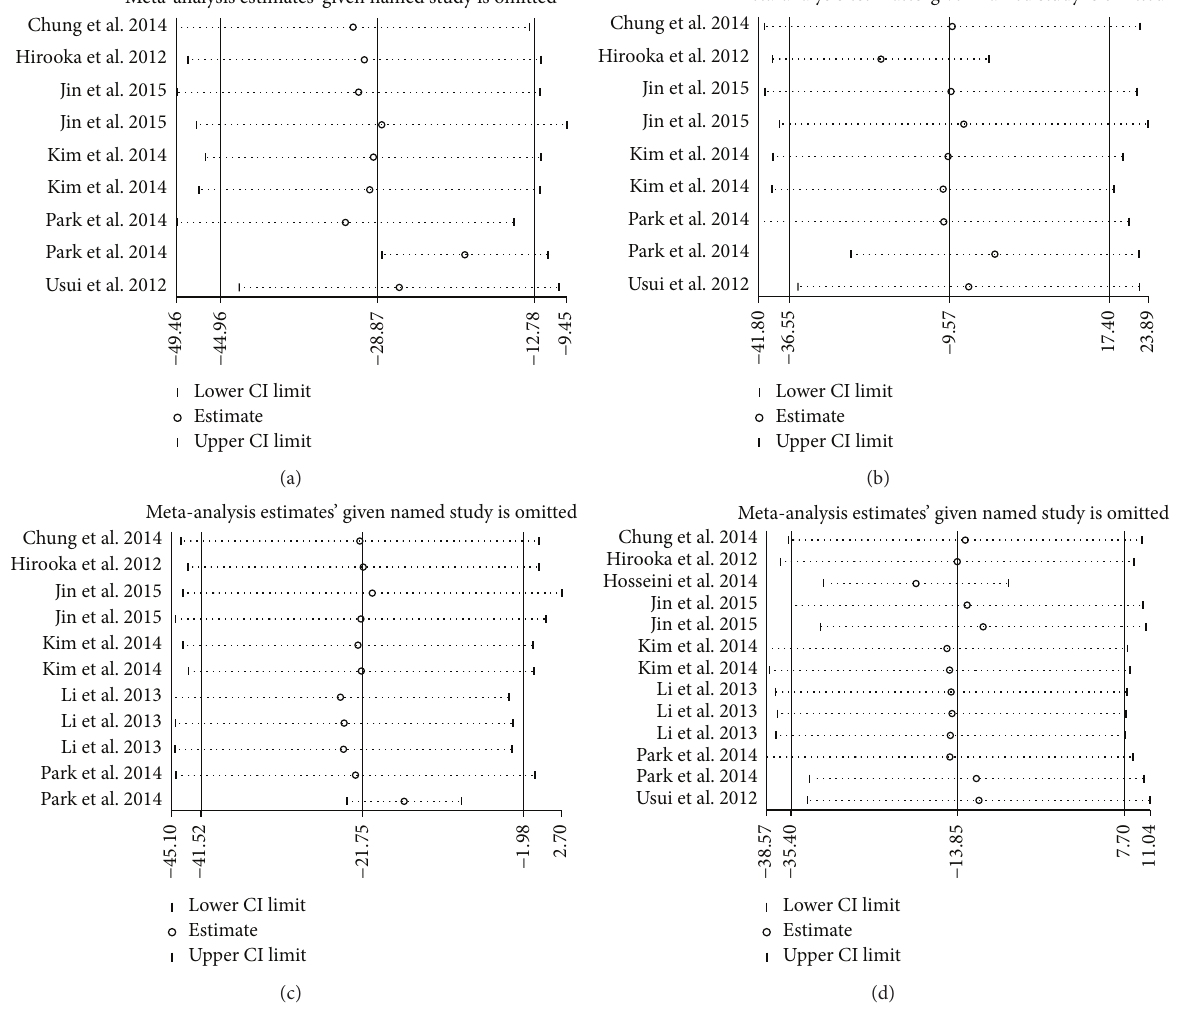
Figure 6: Sensitivity analysis of PPCT in each sector: (a) superior, (b) inferior, (c) nasal, and (d) temporal. CI indicates confidence interval.